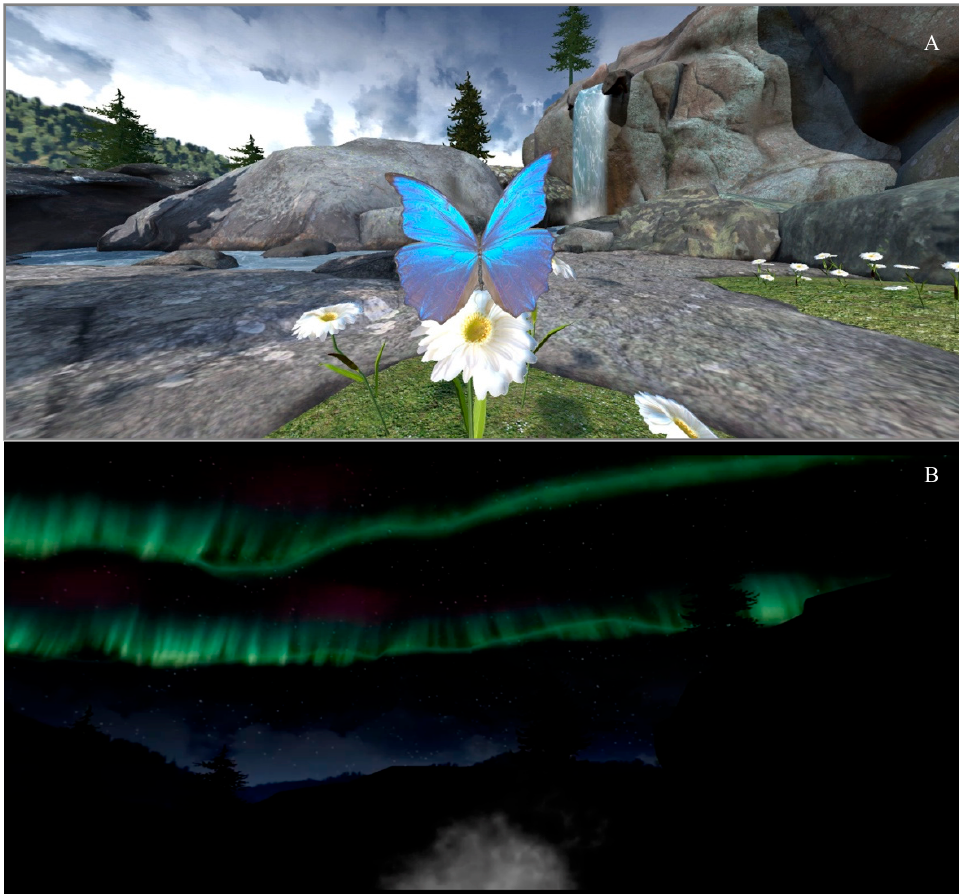
Figure 3. MBVR Experience. ( A ) This panel shows the first scene in MBVR (i.e., peaceful meadow with a waterfall) and the butterfly that supports participants pace their breath. ( B ) This panel displays the second scene in MBVR (i.e., night sky with northern lights) and the breath mist that supports participants pace their breath.